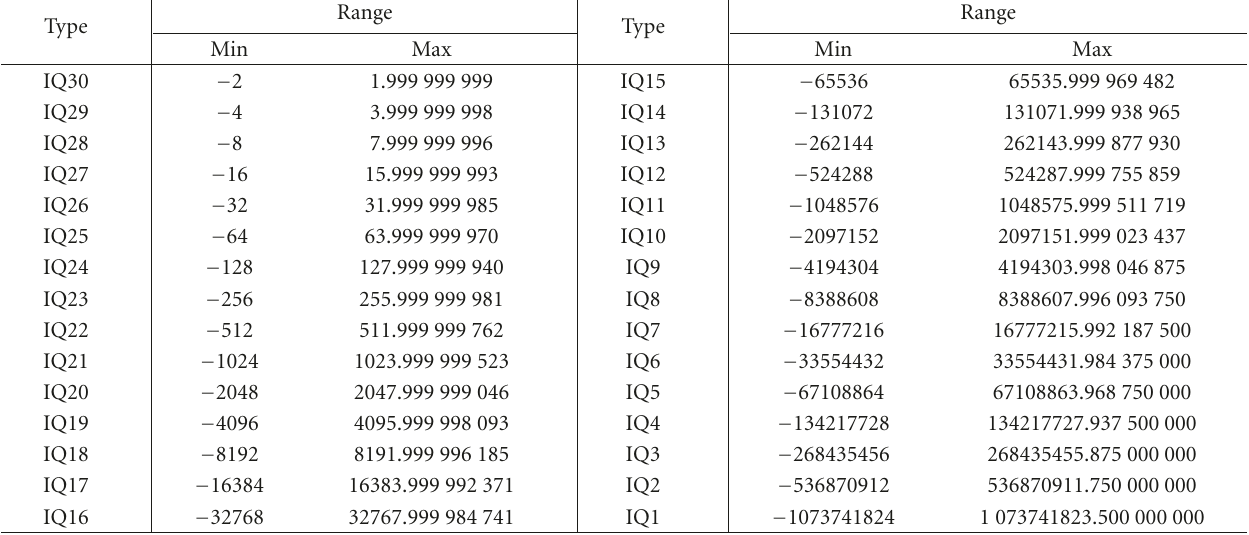
Table 1: Range of 32-bit fixed point number for di ff erent Q format